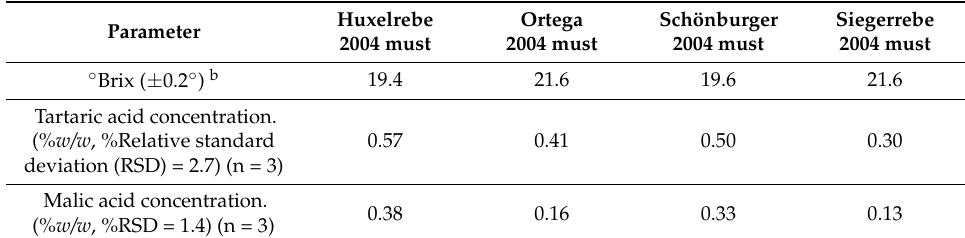
Table 1. Summary of routine enological parameters a